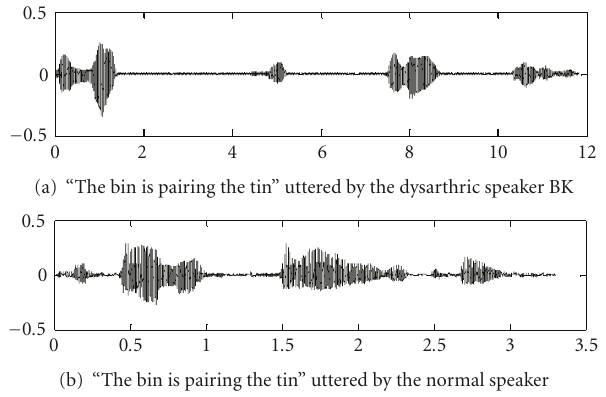
Figure 7: Example of utterance extracted from the Nemours